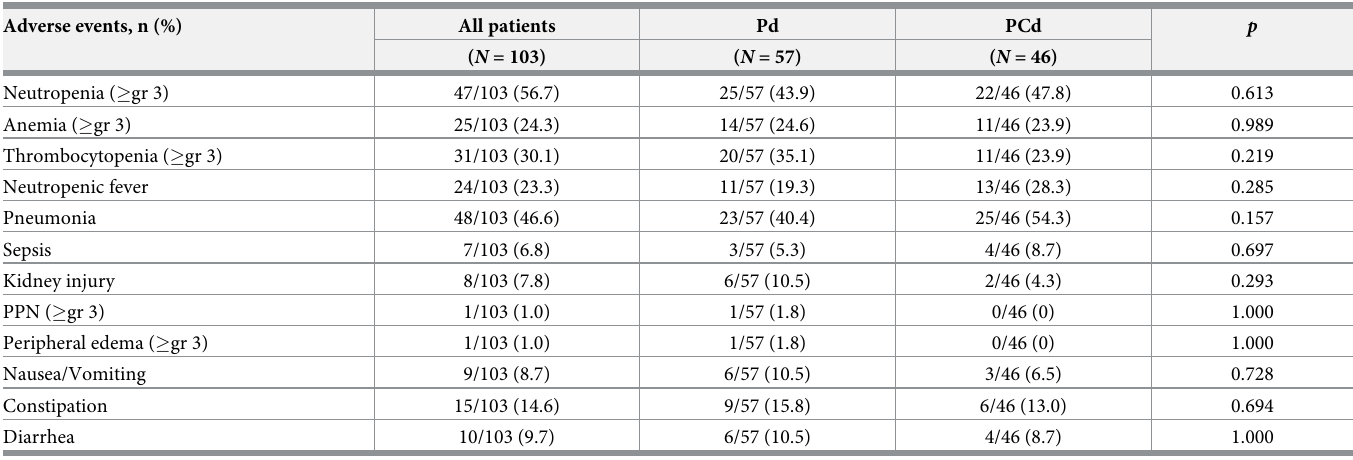
Table 5. Adverse events.